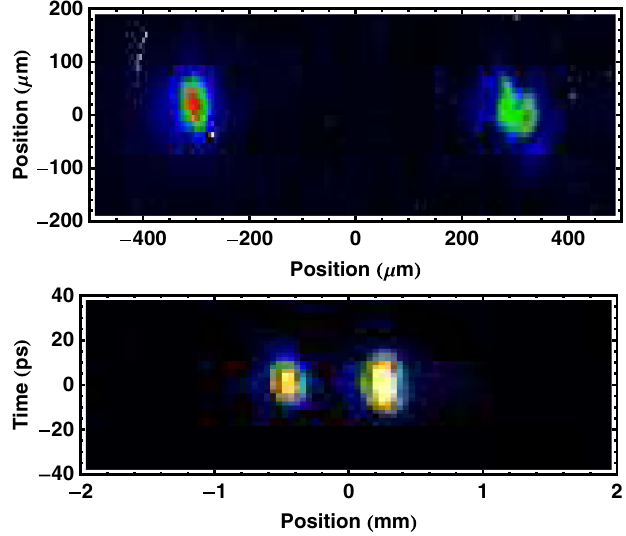
FIG. 9. (Color) Images of the laser and electron beams at the interaction point. Top: Beam spatial profile on alignment cube (electrons left, laser right). Bottom: Streak camera image of the two beams on the alignment cube (laser left, electrons